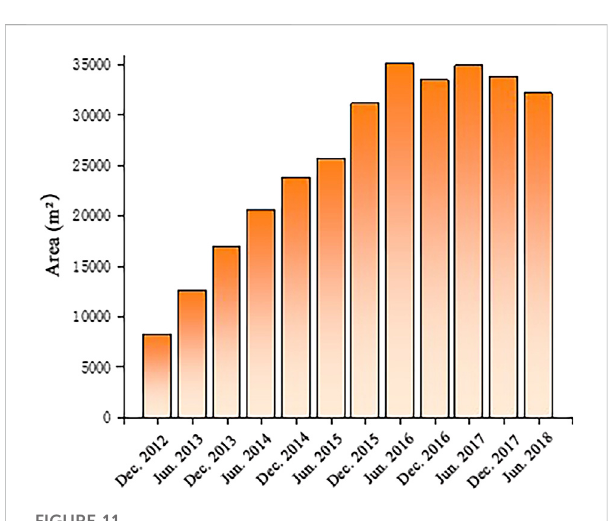
Frontiers in Earth